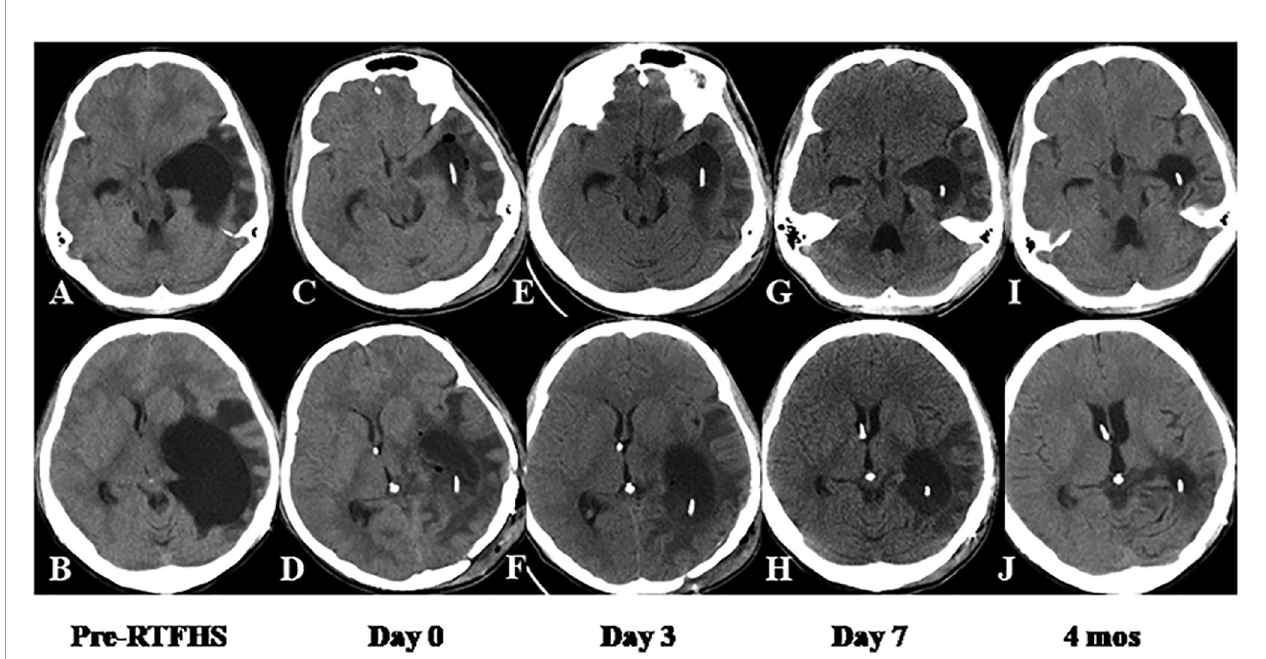
FIGURE 4 | Case 6. CT scan showed immediate and further reduction of TTH volume at the level of midbrain (upper panel) and Foremen of Monro (lower panel). The volume and morphometric changes of TTH were shown before RTFHS (A, B) , at Day 0 (C, D) , Day 3 (E, F) , Day 7 (G, H) , and 4 months (I, J)